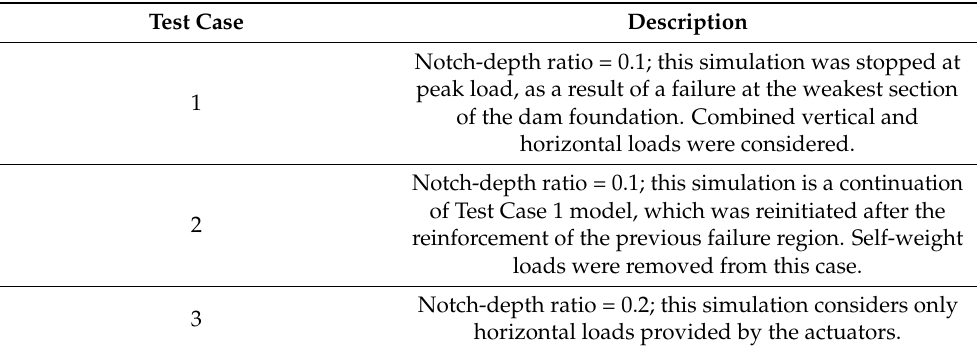
Table 1. Description of experimental models analyzed by Carpinteri et al.